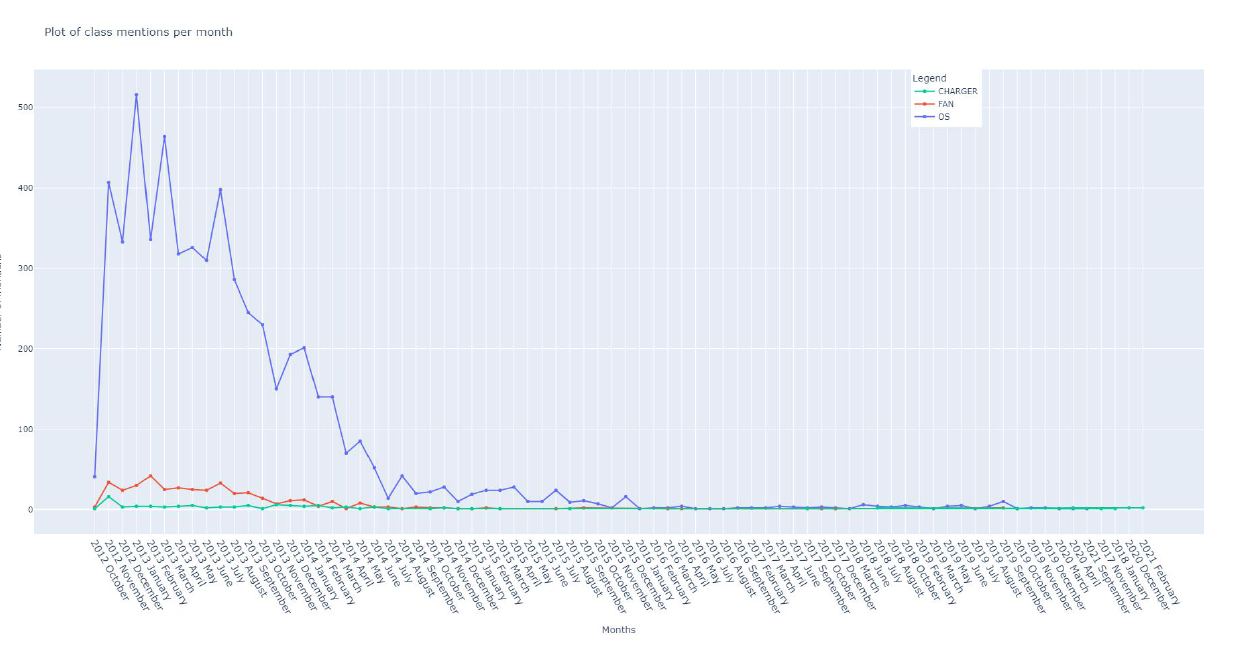
Figure 13. Aspect negative mentions